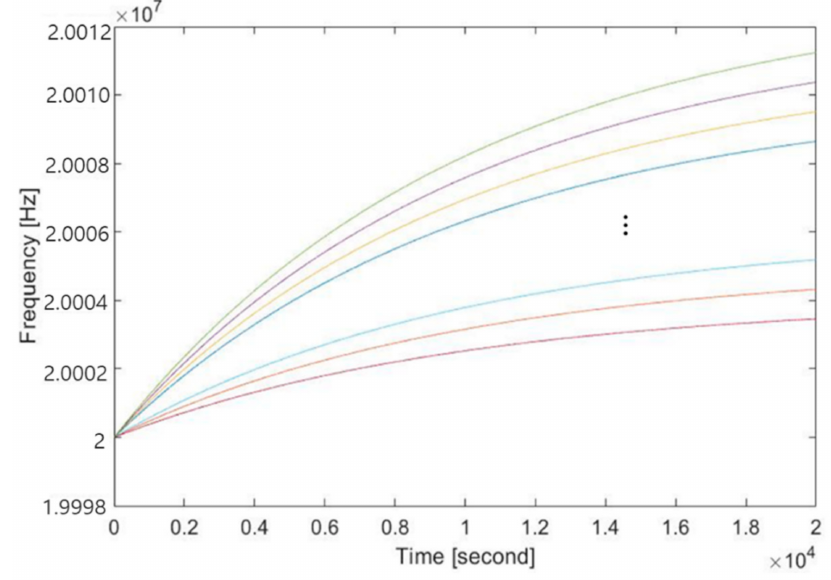
Figure 6. An example of the clock models used in the